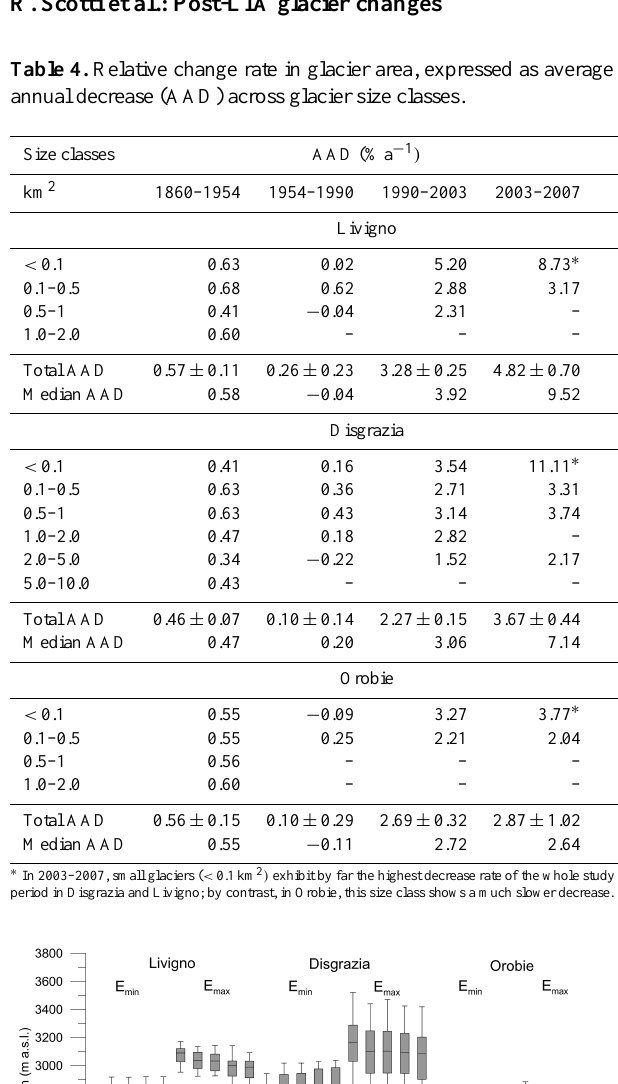
Figure 9. Mean annual elevation change rate (ma − 1 ) and average annual decrease (AAD) in glacier area (km 2 a − 1 ) in (a) Livigno, (b) Disgrazia, and (c) Orobie. Bars indicate uncertainty in glacier area